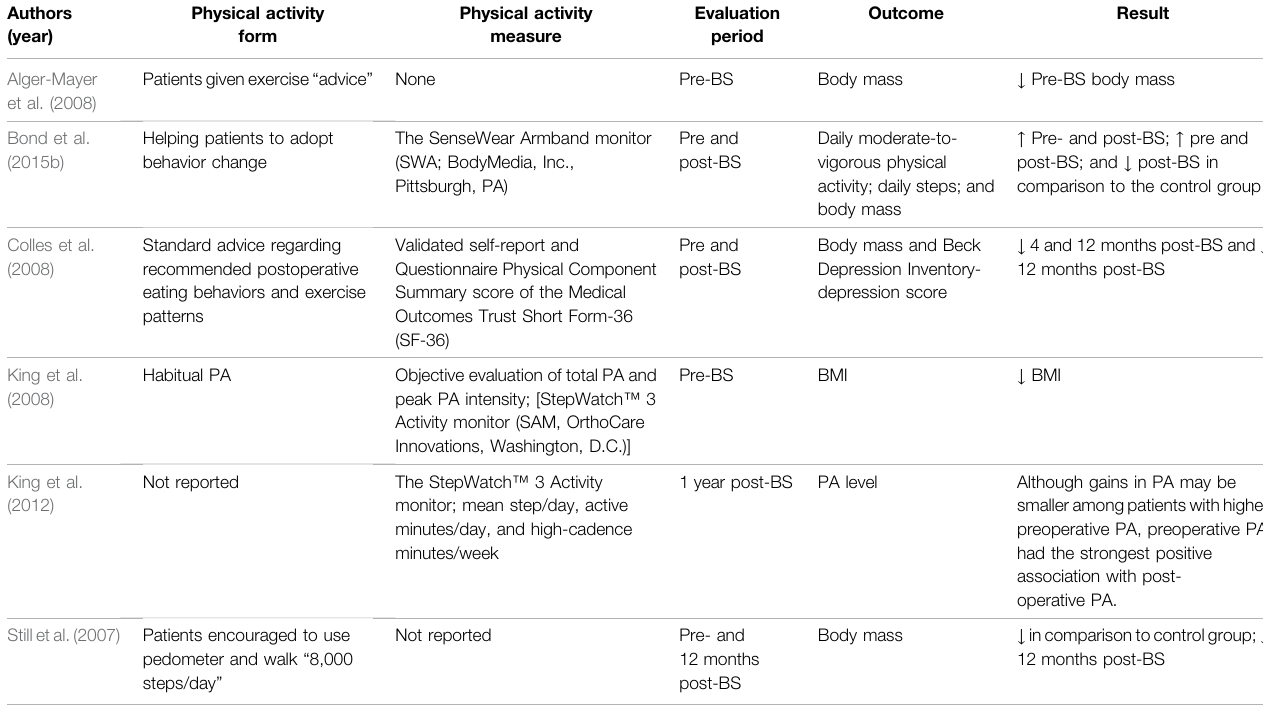
TABLE 4 | Preoperative physical activity and its effects on candidates ’